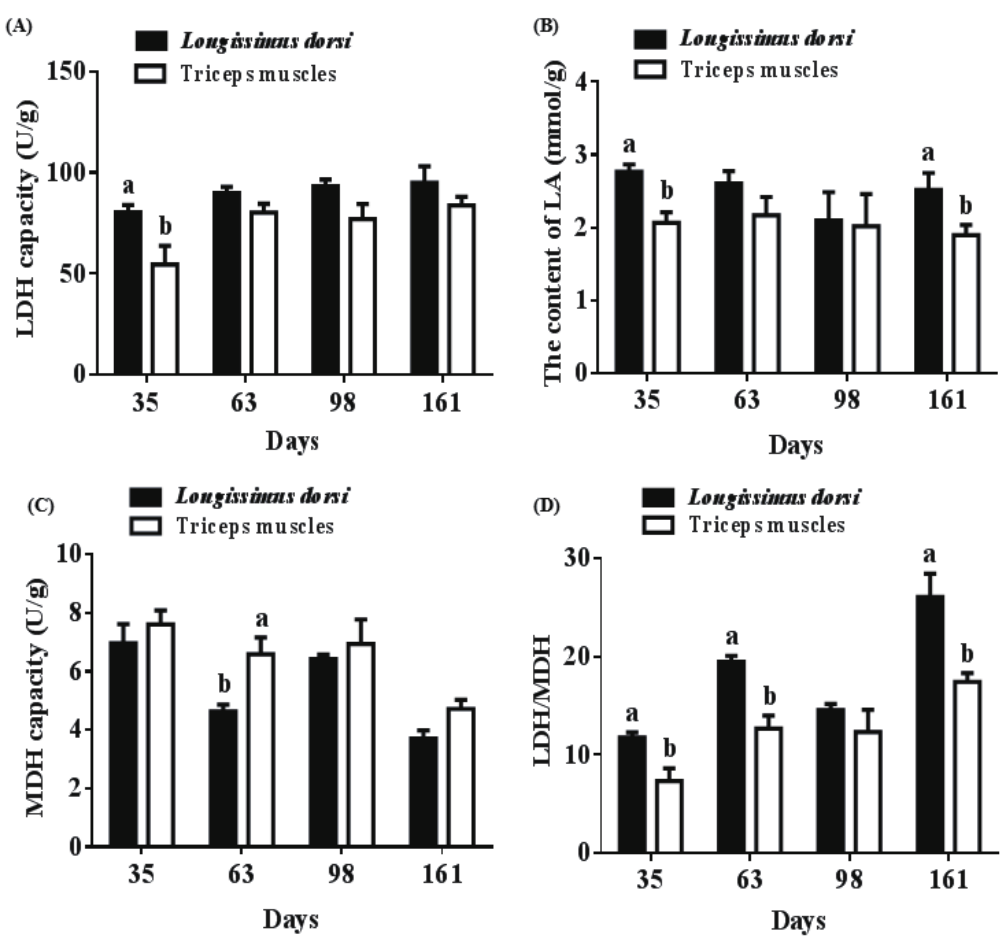
Figure 6. Different muscle profiles of porcine enzyme activities and lactic acid (LA). (A) Differences in lactic dehydrogenase (LDH) content between longissimus dorsi and triceps muscles. (B) Differences in LA content between longissimus dorsi and triceps muscles. (C) Differences in malate dehydrogenase (MDH) content between longissimus dorsi and triceps muscles. (D) Differences in the ratio of LDH/MDH between longissimus dorsi and triceps muscles. Mean with different superscripts demonstrate significant difference among groups (p<0.05), n =